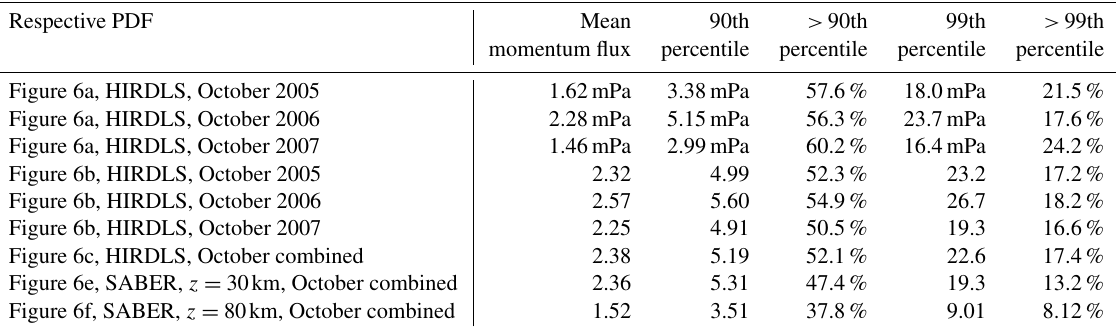
Table 2. Means, 90th percentiles, and 99th percentiles as well as fractions of gravity wave absolute momentum fluxes at values beyond the respective percentiles for the PDFs of momentum fluxes and normalized momentum fluxes shown in Fig. 6 for the month of October in the latitude band from 50 to 65 ◦ S.